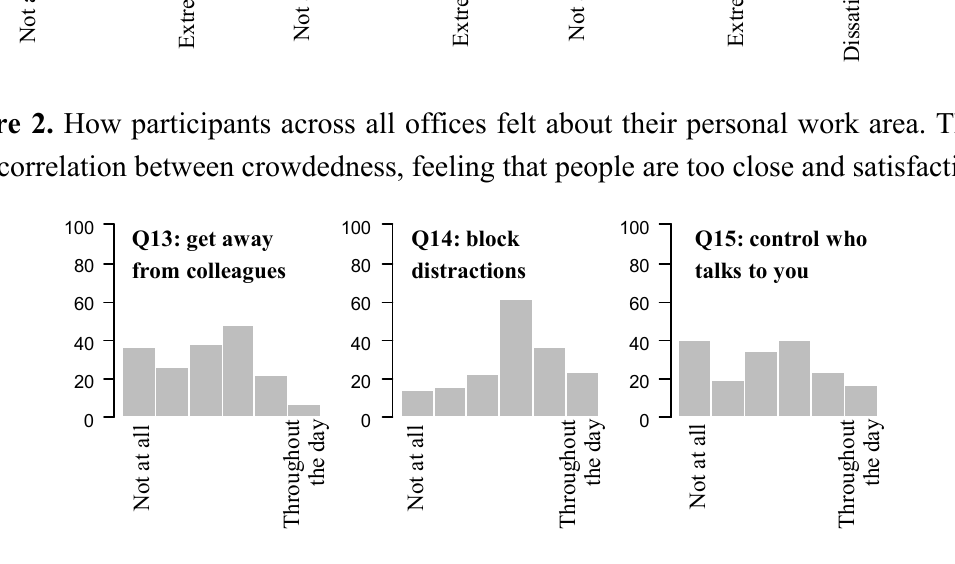
Figure 3. How often participants from all offices need to carry out